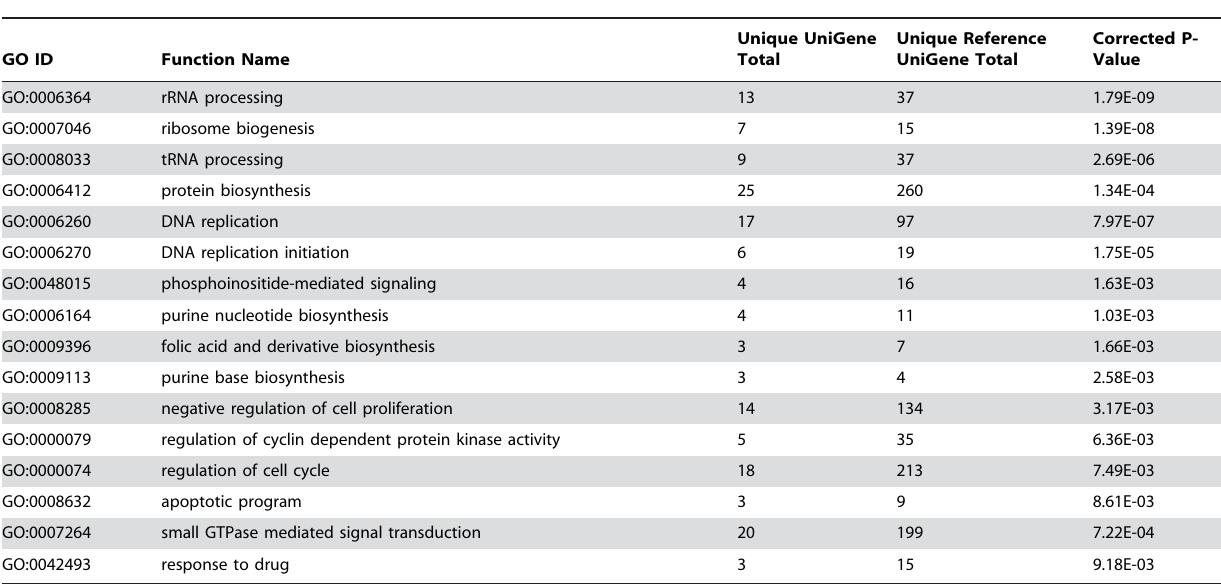
Table 1. Gene ontology of all estrogen-regulated